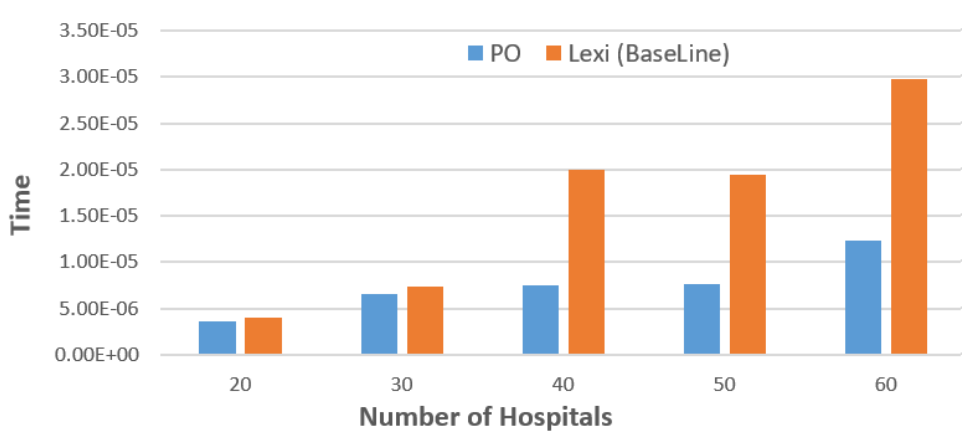
Figure 3. A comparison between Pareto optimization and the lexicographic method according to the average running time in